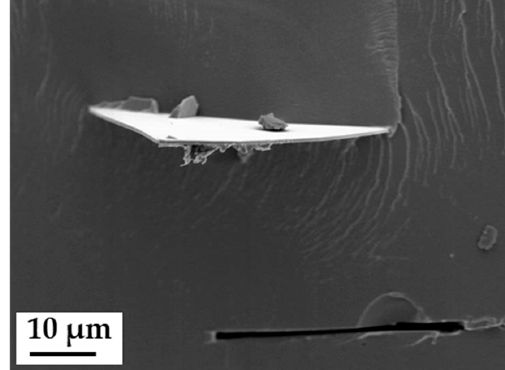
Figure 1. Scanning electron microscope (SEM) micrographs (secondary electrons) of a cryofractured composite membrane with a planar-oriented glass platelet (upper half of picture), and a vacancy of a ripped off platelet (lower half of picture).